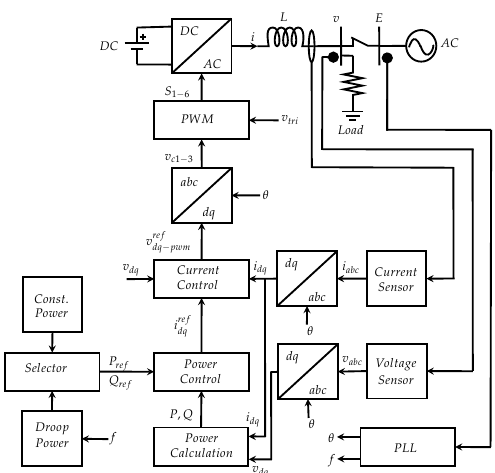
Figure 9. Grid-injecting control of grid-connected inverter.